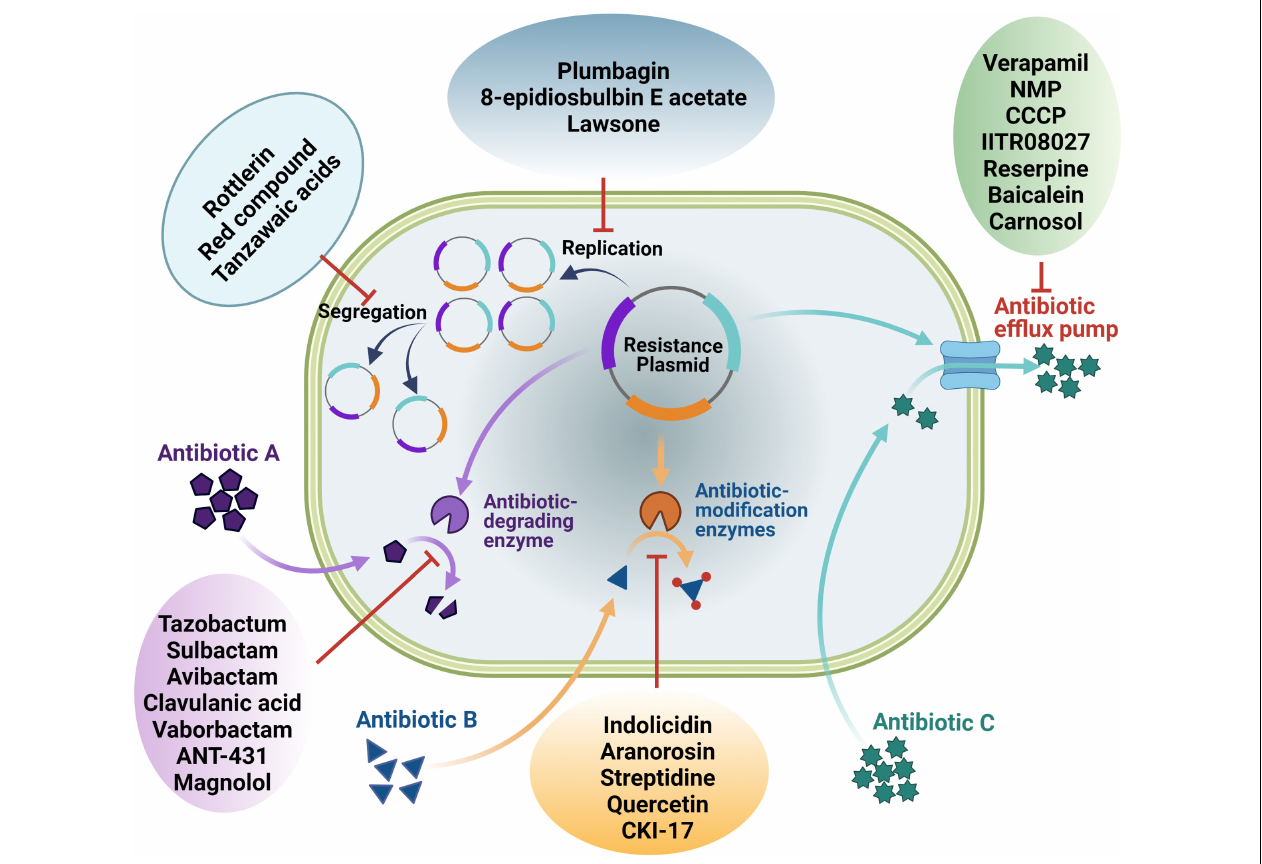
FIGURE 1 | An overview of different ways of antibiotic resistance reversal by different antibiotic potentiators. Potentiators may work directly on the resistance functions or indirectly on the genetic elements linked with the resistance